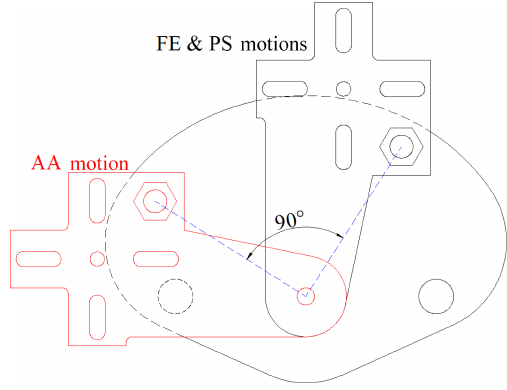
Figure 11. Two positions of the part carrying the exoskeleton.